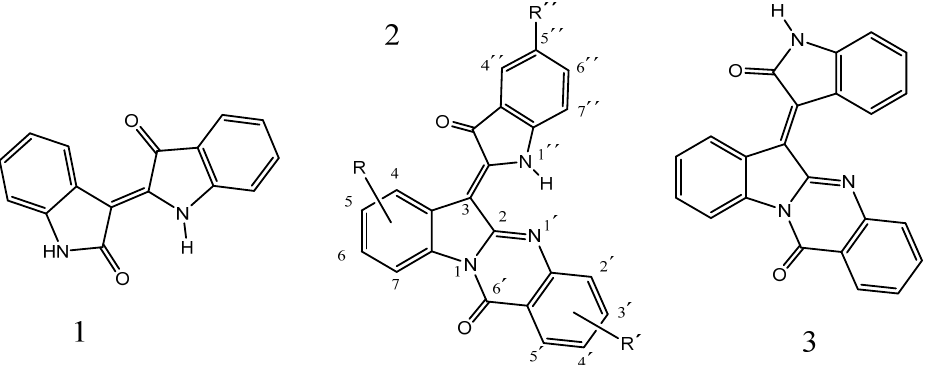
Figure 1. Structures of indirubin 1 , candidine/quingdainone 2, i.e., (Z)-6-(3-oxoindolin-2-ylidene)indolo[2,1-b]quinazolin-12(6H)-one, and its isomer (E)-6-(2-oxoindolin-3-ylidene)indolo[2,1-b] quinazolin-12(6H)-one 3, originating from isoindigo.